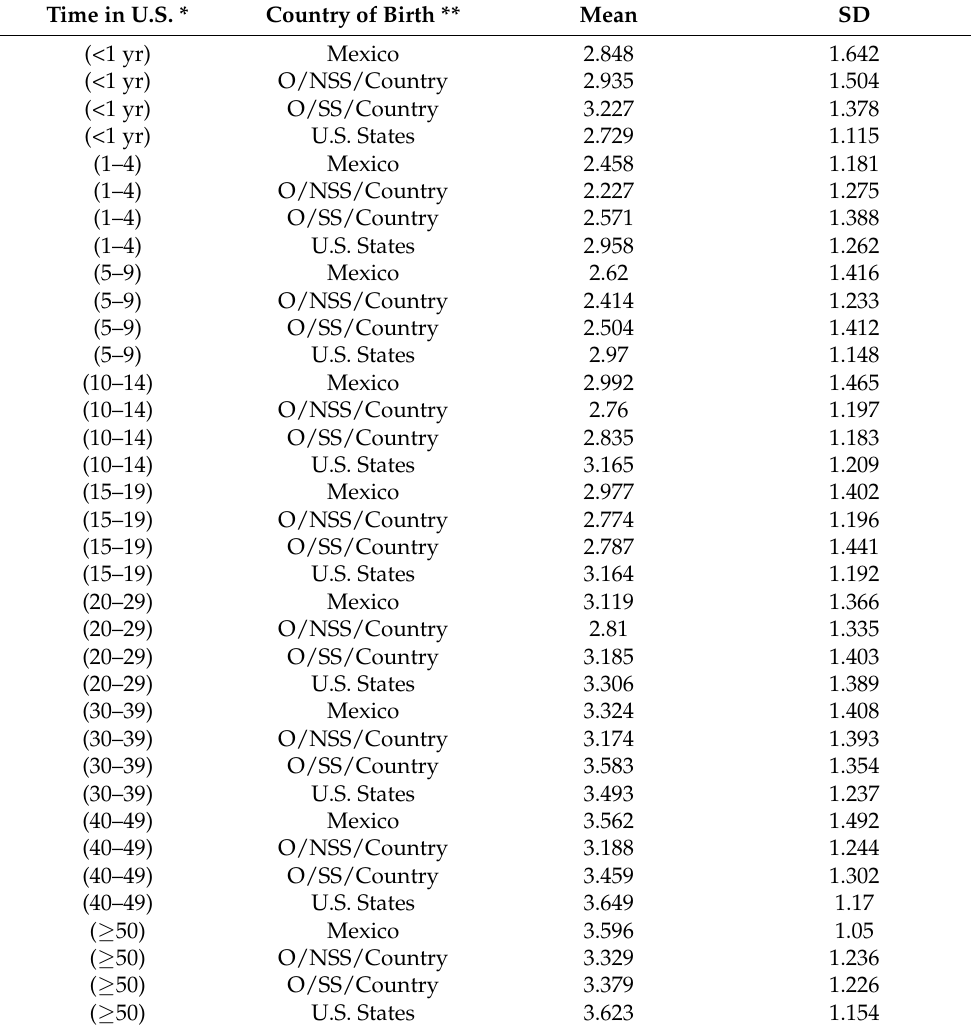
Table 1. AL level by country of birth and length of time in U.S. Time in U.S.